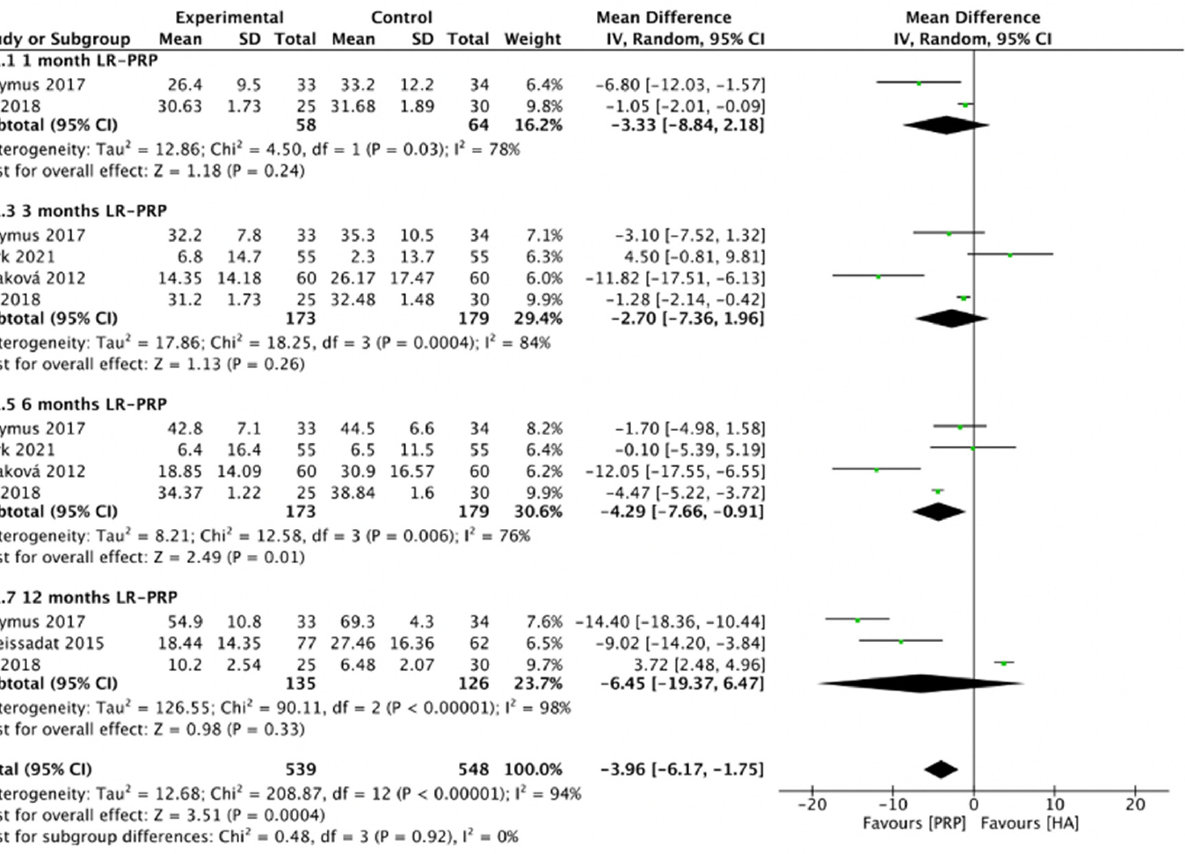
Figure 4. Trials of LR-PRP versus HA. Forest plot of WOMAC total scores. (IV, inverse variance; CI, confidence interval; SD, standard deviation).